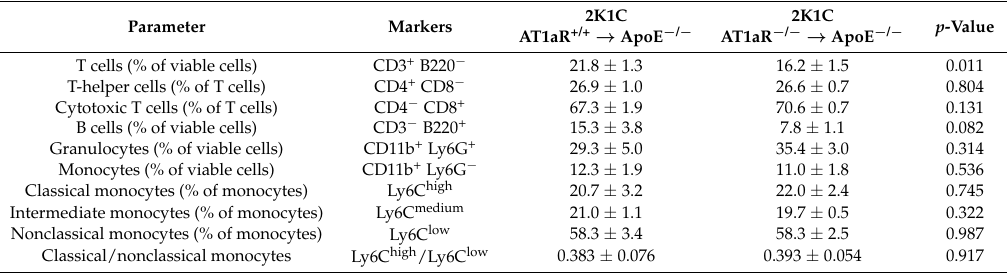
Table 2. Flow cytometry analysis of blood leukocytes in 2K1C ApoE − / − mice transplanted with AT1aR +/+ or AT1aR − / − BM